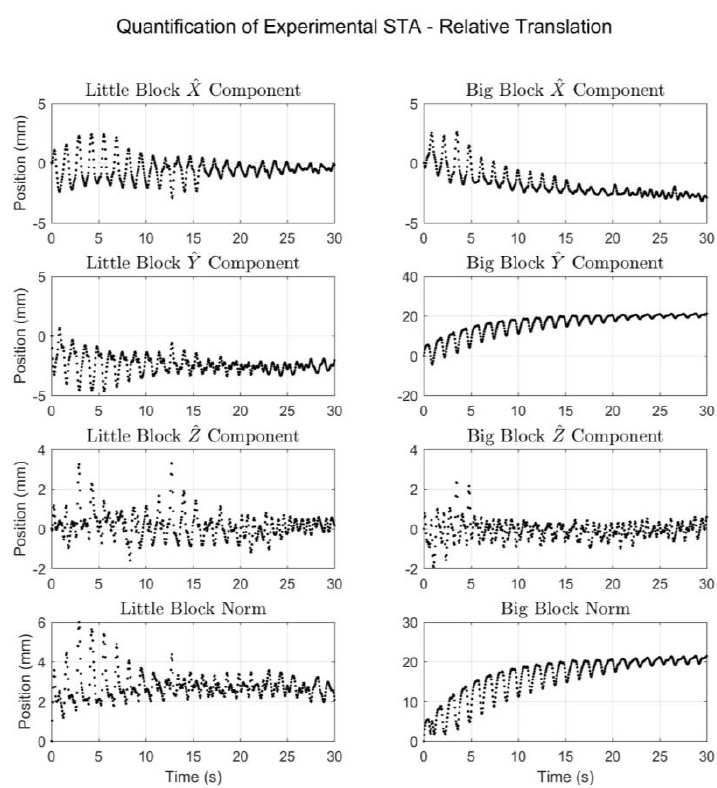
Figure 10. The translational motion of the meat sensor relative to the rigid sensor in terms of the local 𝑋̂ , 𝑌̂ , and 𝑍̂ components and the norm for both the little block trial ( left ) and the big block trial ( right ).